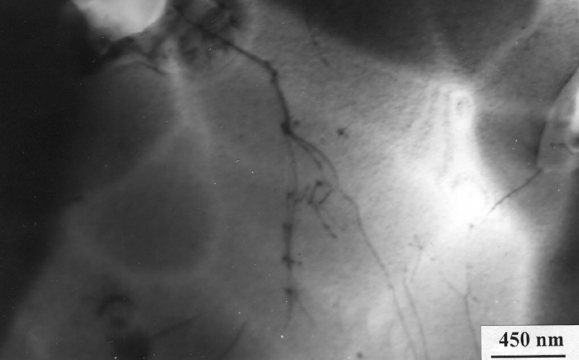
Fig. 4: Micrographs of thin foil (TEM) of MoSi 2 + 10% nano SiC composite after creep (1473 K, 100